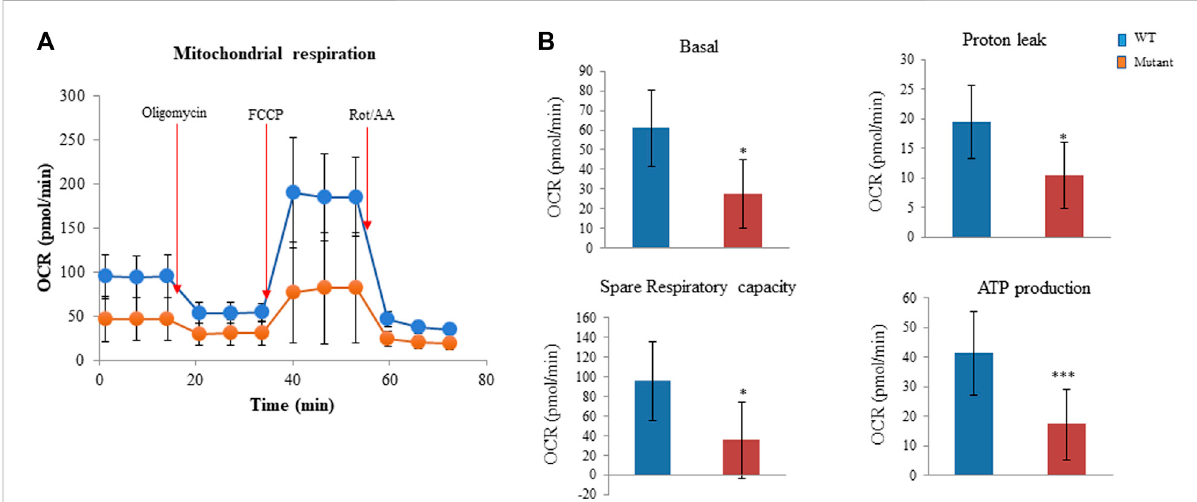
FIGURE 5 PGAM2 K176R/K176R mutation impairs mitochondrial function. For measuring the oxygen consumption rate (OCR), C2C12 cells were seeded into 96-wellSeahorsecellcultureplatesandculturedovernight.TheSeahorseXFe96ExtracellularAnalyzerwasusedtorecordOCRatbaselineandthree times at 6-min intervals after injections with 5 µM oligomycin, 3 µM FCCP, and 4 µM rotenone/antimycin A (Rot/AA), respectively, according to the manufacturer ’ s protocol. Data were automatically generated by Seahorse XF Cell Mito Stress Test Report Generator. (A) One representative